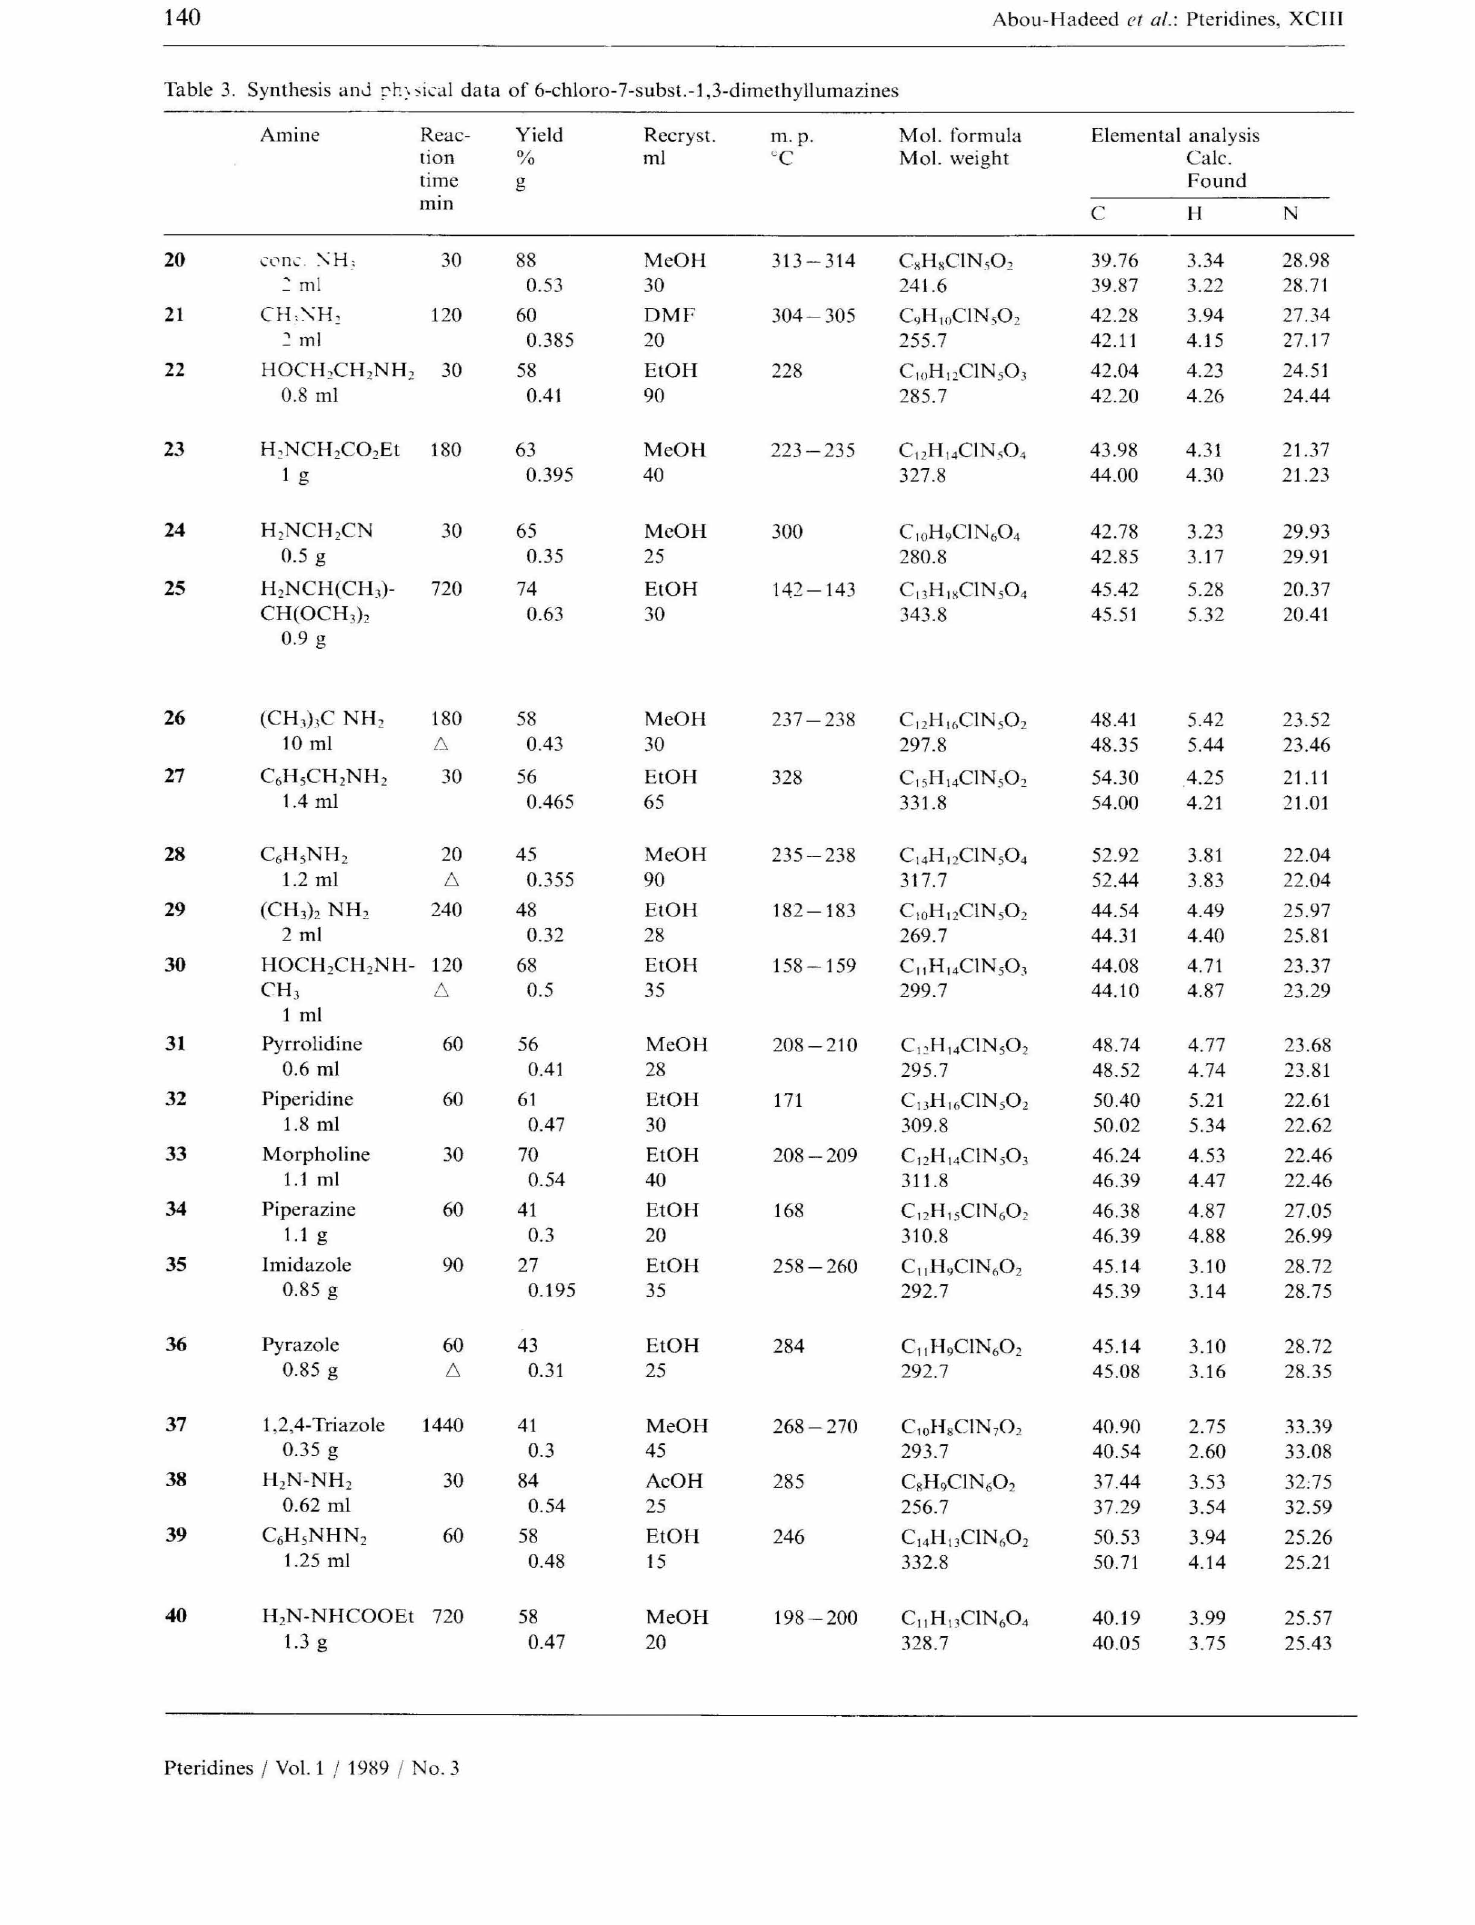
Table 3. Synthesis anJ rh\ ,lcal data of 6-chloro-7-subst.-l